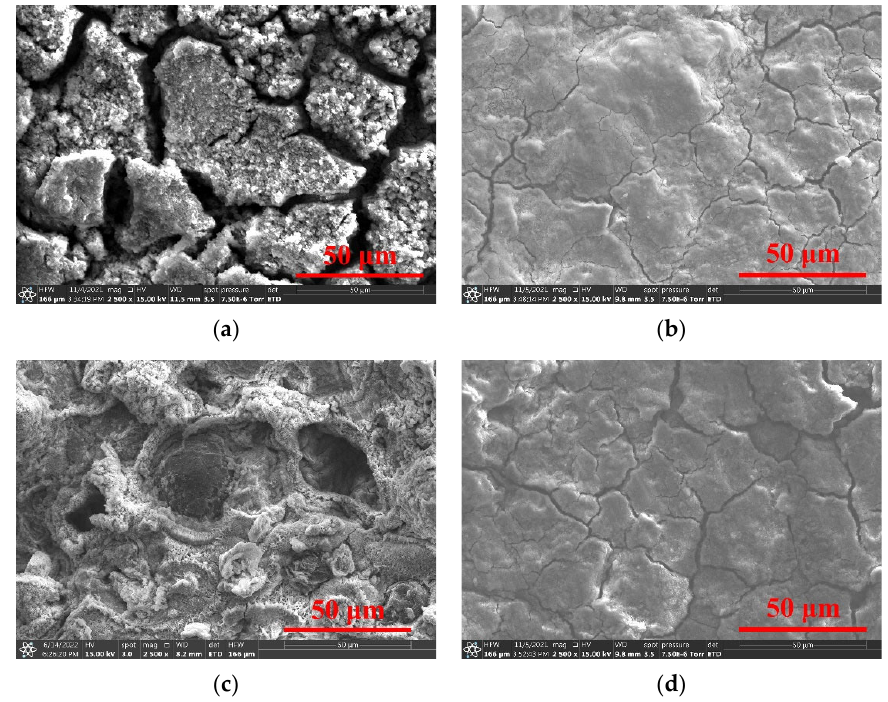
Figure 13. SEM of original surface in area A ( a ) and B ( c ); converted with PC in area A ( b ) and B ( d